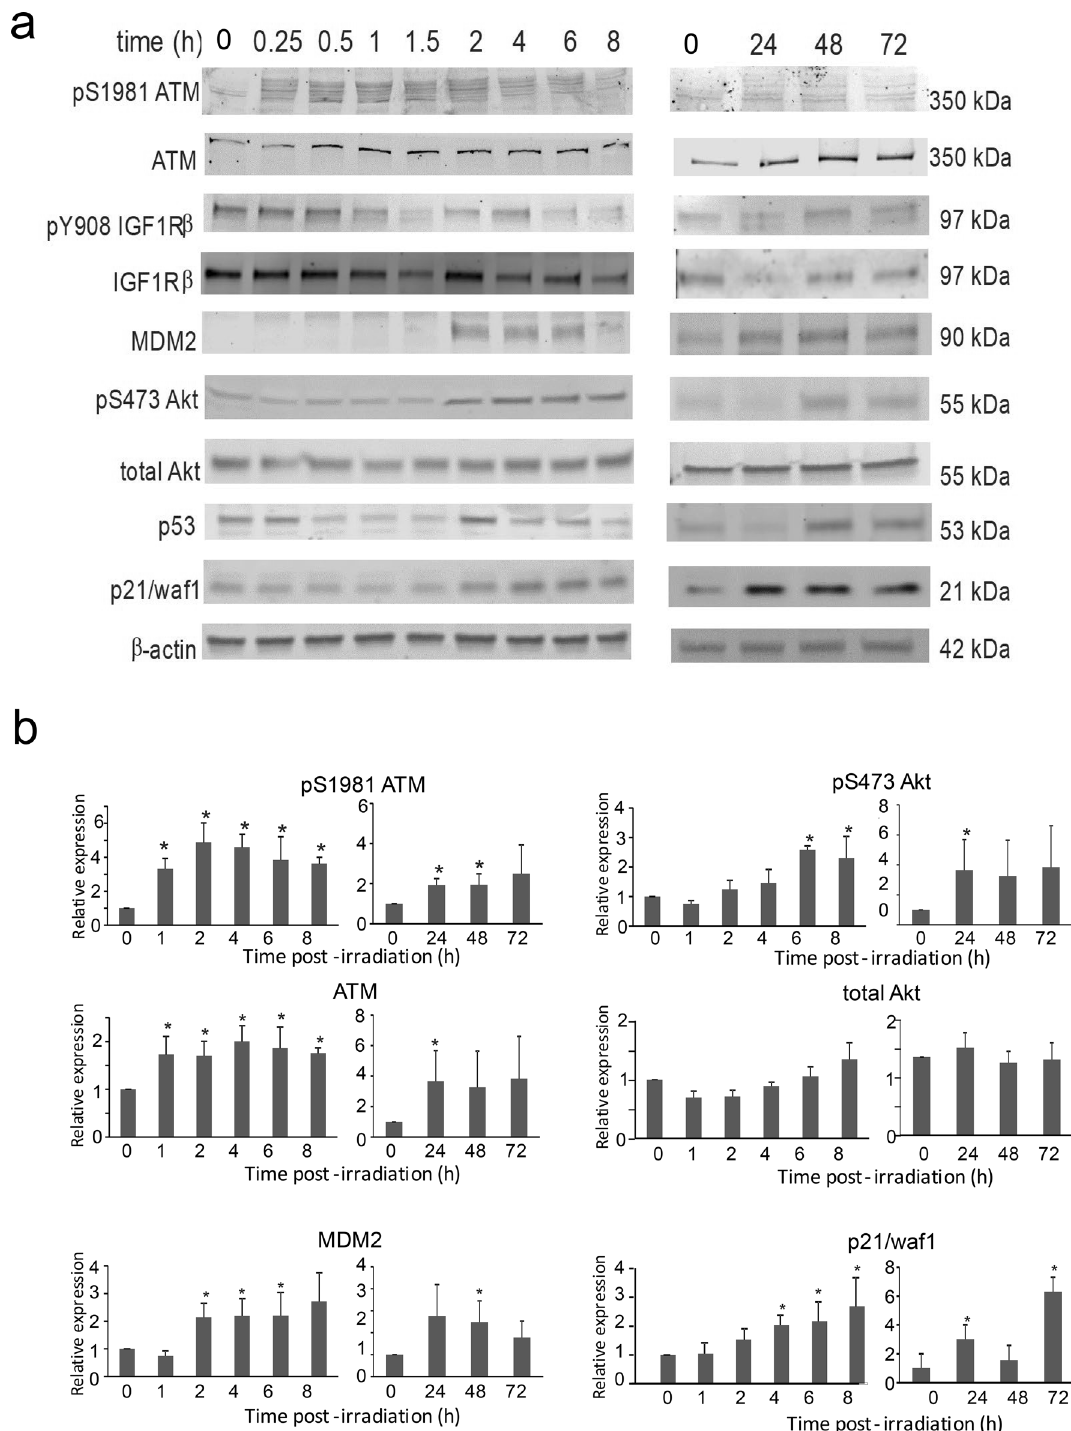
Figure 3. Changes in protein levels and phosphorylation in irradiated HLMVEC. HLMVEC were grown to 70% confluence and exposed to 10 Gy X-ray irradiation. Protein lysates were prepared at the indicated time points and used for western blotting for the indicated proteins and phospho-proteins. ( a ) Representative blots are shown from 3 independent experiments for (from top to bottom) pS1981 ATM, total ATM, pY908 IGF1Rβ, total IGF1Rβ, MDM2, pS473 Akt, total Akt, p53, p21/waf1, and β-actin. ( b ) Densitometry was performed for pS1981 ATM, total ATM, pS473 Akt, total Akt, MDM2, and p21/waf1. Graphs indicate means, normalized to β-actin protein levels, ± SEM from 3 independent experiments. * indicates p <